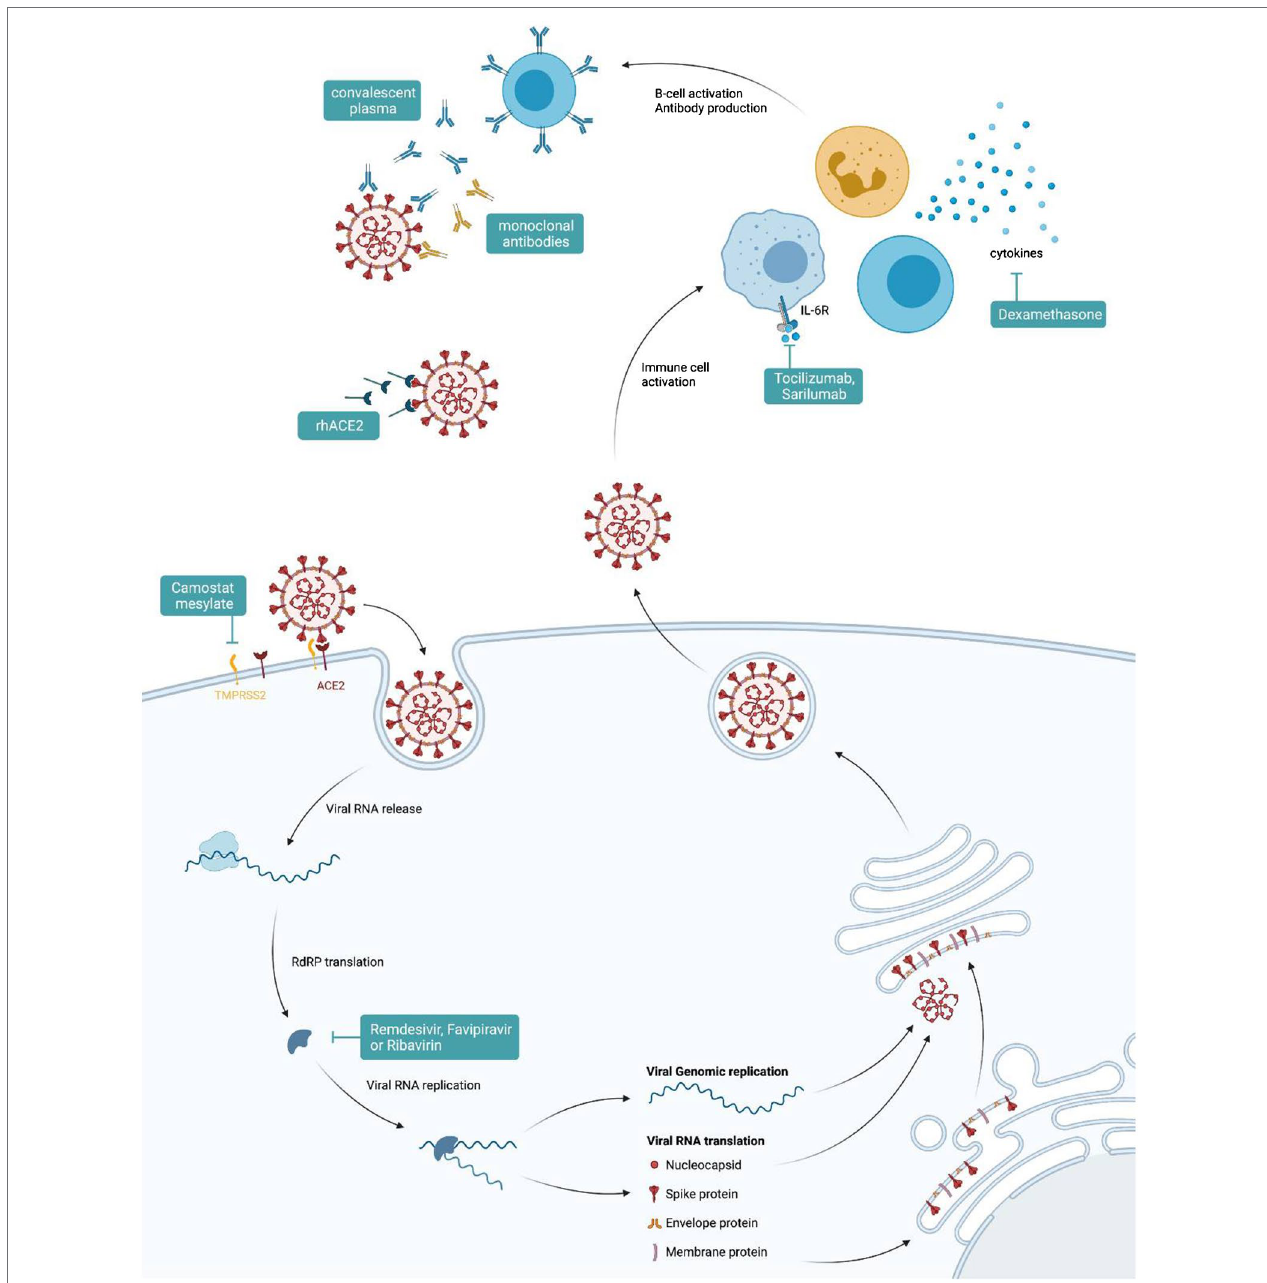
FIGURE 3 | Therapeutic options for COVID-19. Graphical representation of points of attack for available therapies against severe acute respiratory syndrome coronavirus-2